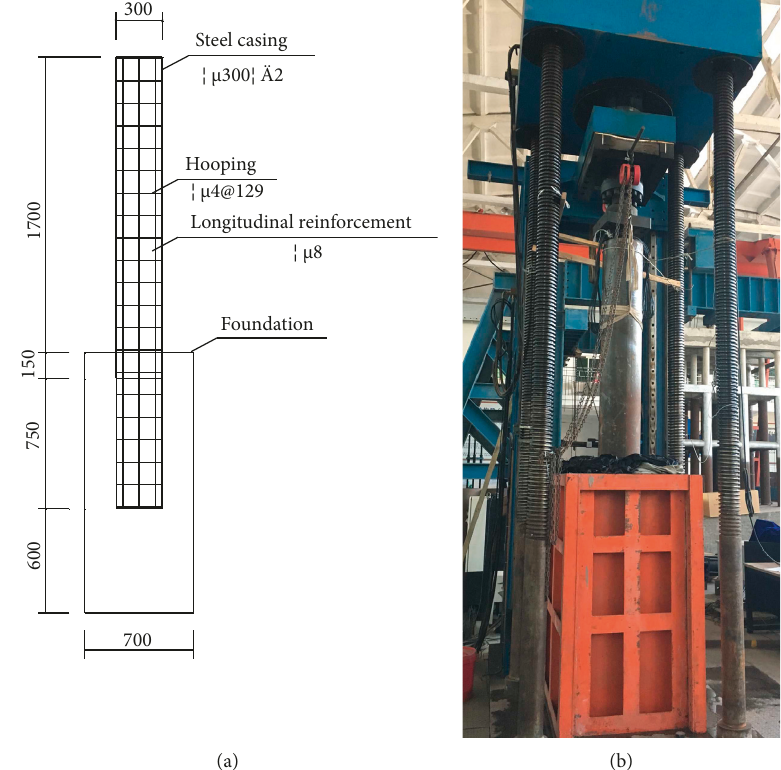
Figure 1: Schematic diagram of model pile structure (unit: mm). (a) Structural elevation; (b) physical